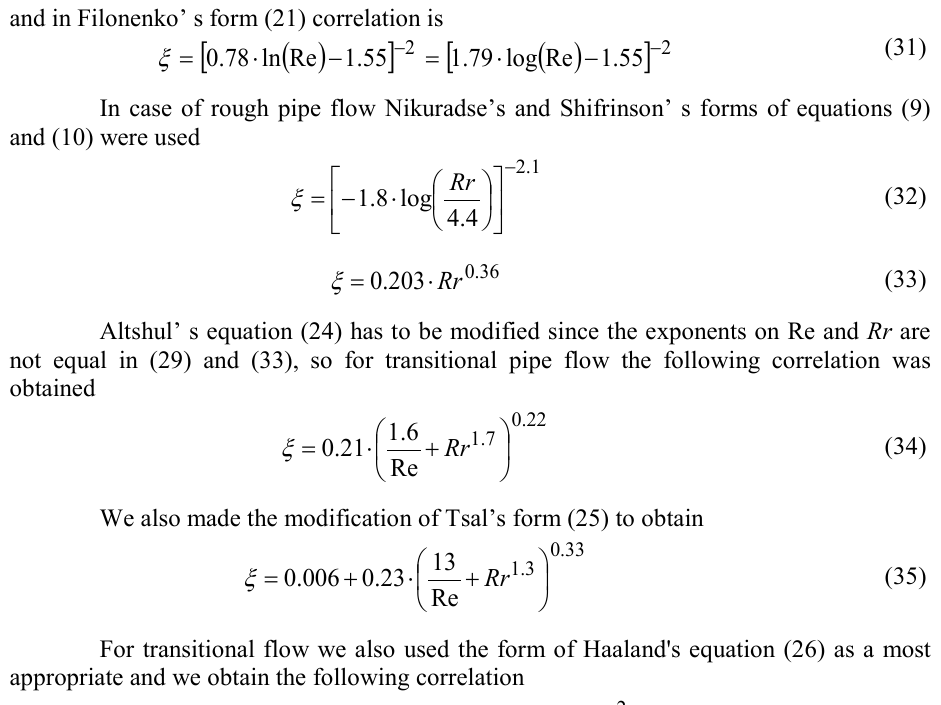
Table 3 Review of the correlations for turbulent flow in rough pipes (database z = 181)